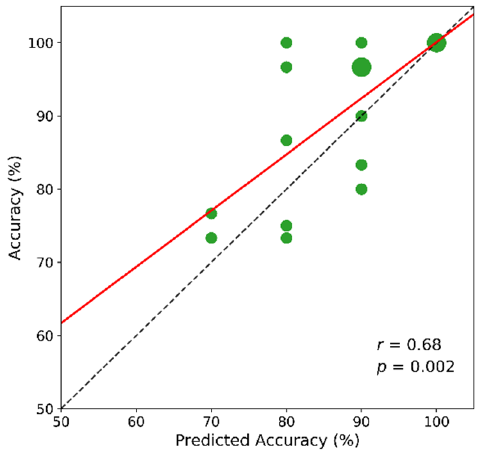
Figure 11. Actual accuracy and users’ self-predicted accuracy. The circle size represents the number of subjects in that point. The dashed line is the y = x line and the solid red is the regression line on the given points.